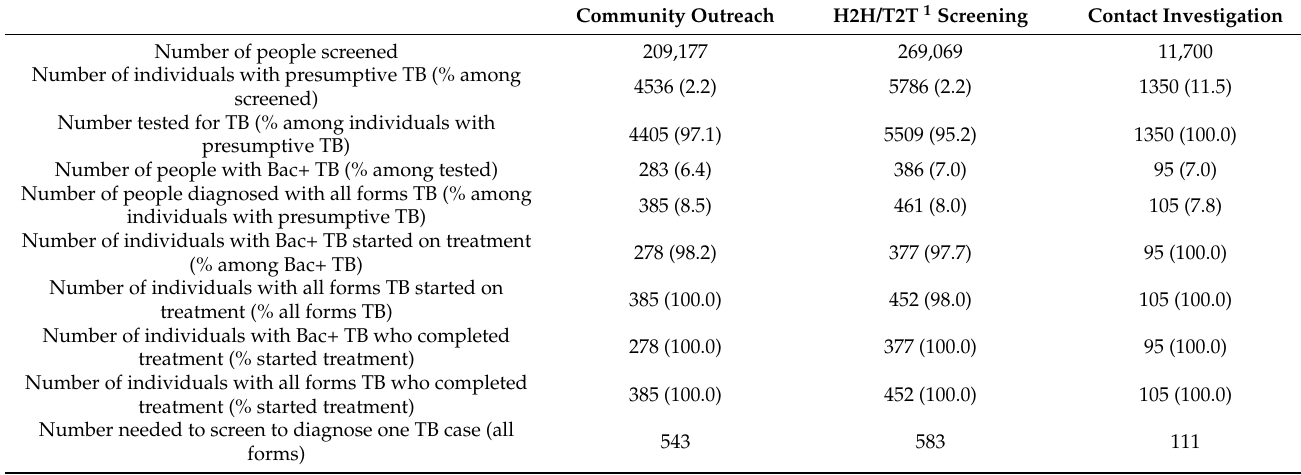
Table 4. Results of the intervention by approach in lbeno, Oron, Mbo (Akwa Ibom) and in Biase, Obubra and Odukpani (Cross River) by approach.